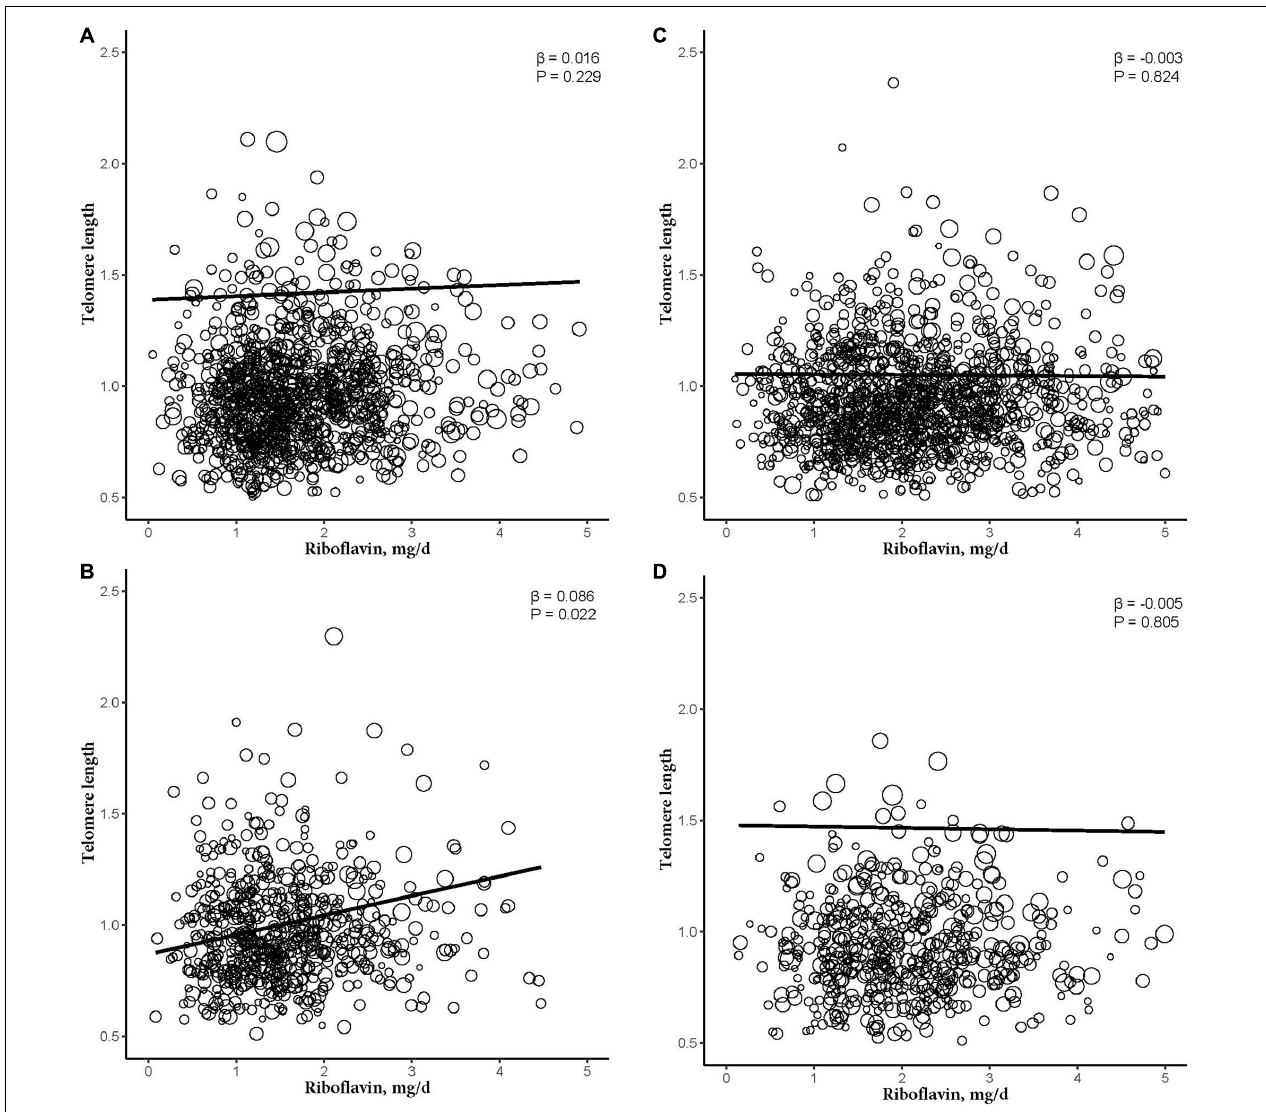
FIGURE 3 | The dose-response relationship between riboflavin intake and telomere among sex and obese subgroup. (A) Non-obese female participant. (B) Obese female participant. (C) Non-obese male participant. (D) Obese male participant. Models were adjusted for age, ethnicity, education levels, smoking, alcohol consumption, BMI, vitamin C intake, vitamin B12 intake, selenium intake, zinc intake, copper intake, dietary fiber intake, coronary heart disease, congestive heart failure, and diabetes